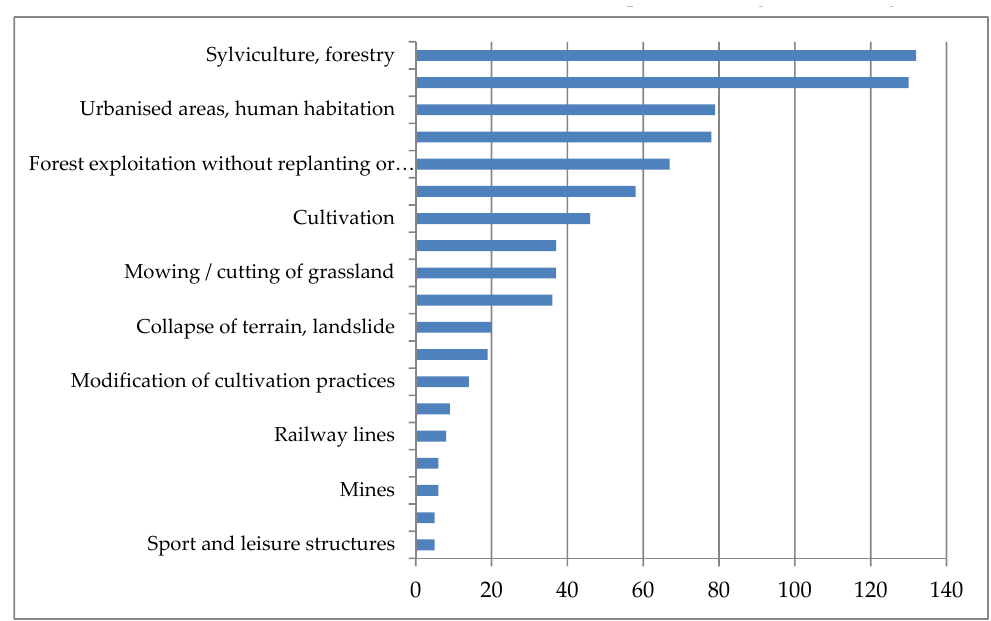
Figure 20. Absolute frequency for threats and pressures, derived from CLC changes, in ROSCI sites.